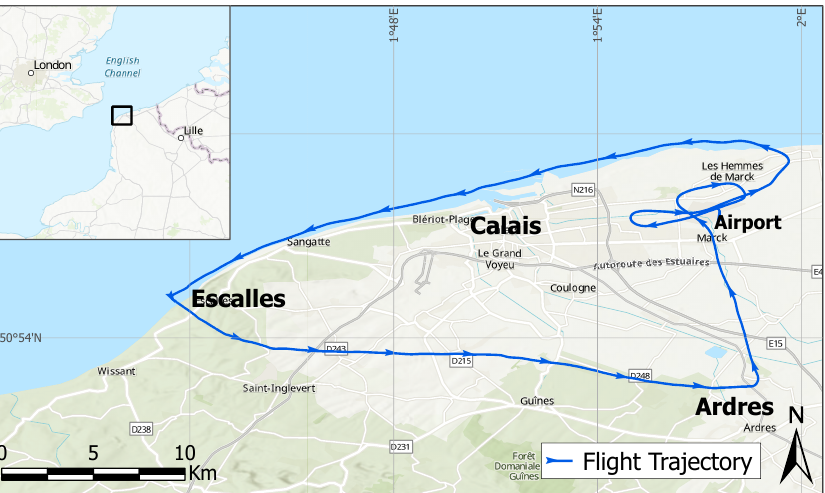
Figure 11. Flight trajectory. Geographical setting of the study area (the WGS84 Universal Transverse Mercator UTM datum corresponds to Zone 31U